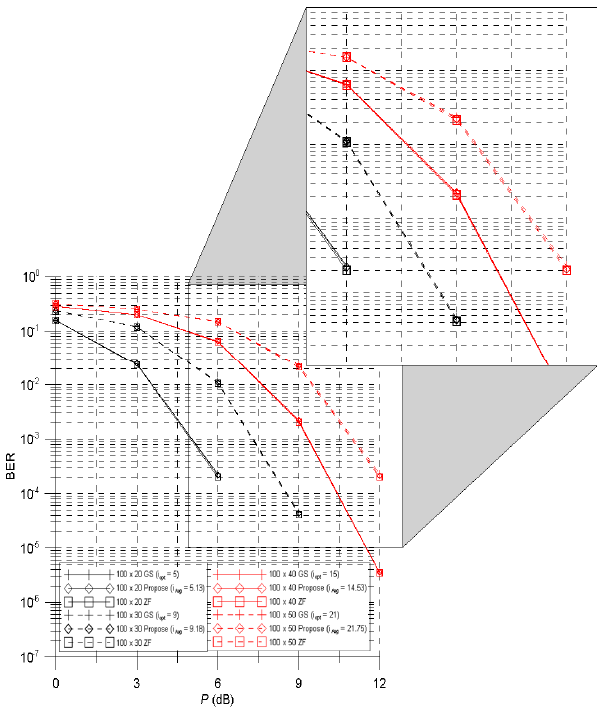
Figure 11. The BER performances for GS pre-coding based on the number of optimal iterations, GS pre-coding based on the proposed estimation scheme, and ZF pre-coding in 100 × 20, 100 × 30, 100 × 40, and 100 × 50 systems when an initial solution is s and 16-QAM is used in Rician fading NS,Stair (The LoS is applied to the first path and K factor is set as 5 dB).